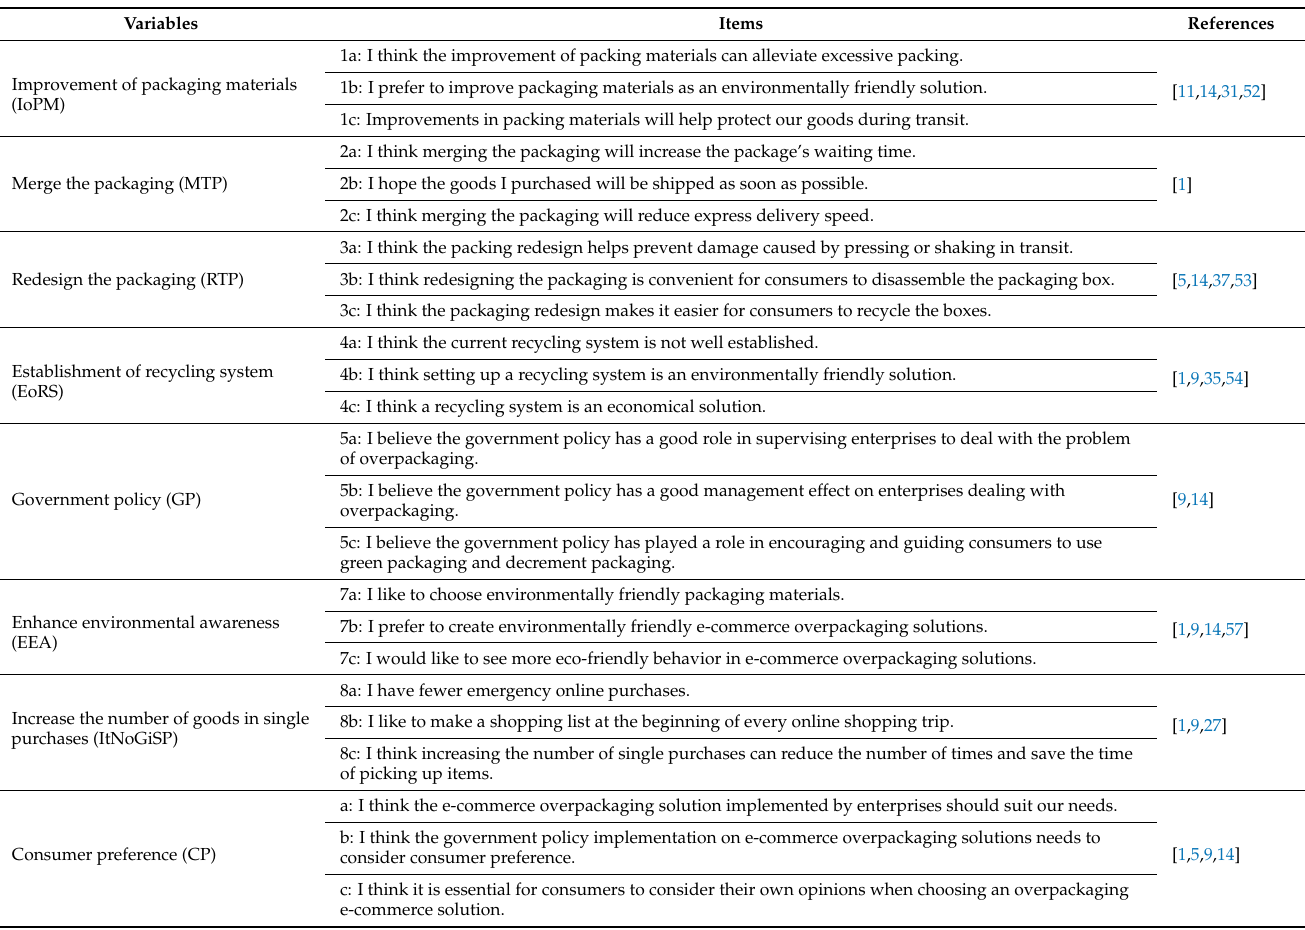
Table 2. Items of constructs in the proposed